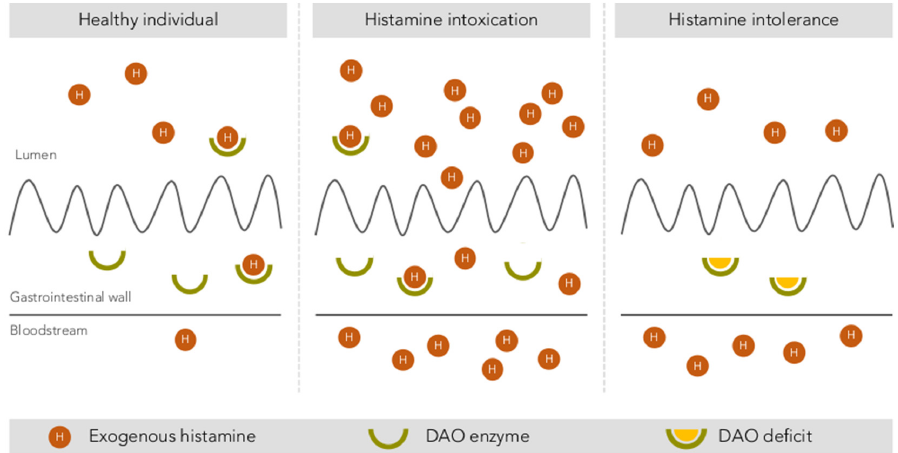
Figure 3. Intestinal degradation of histamine by the DAO enzyme in three different situations: in a healthy individual, with histamine intoxication and with histamine intolerance. Adapted from [13].